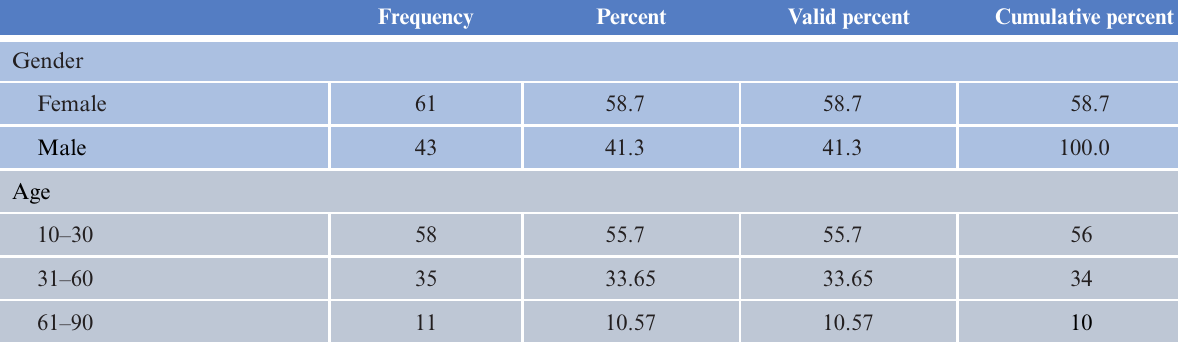
Table 1: Gender and age of AKI patients.